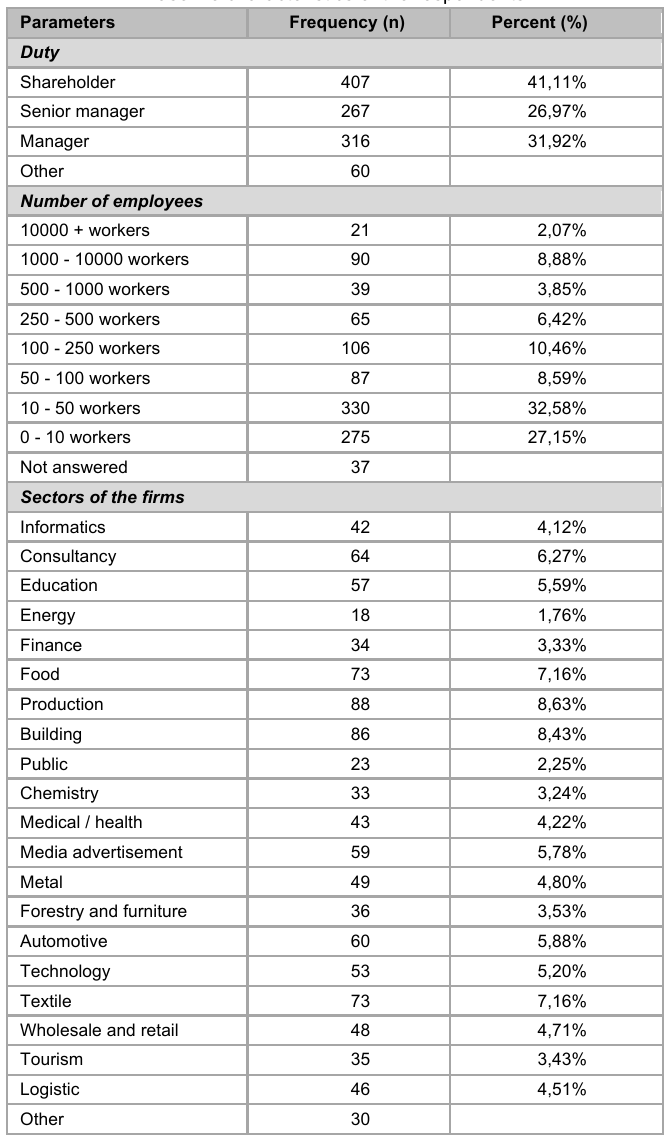
Baseline characteristics of the